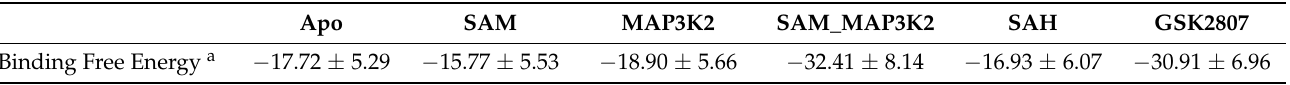
Table 3. Binding free energies of the SET and MYND domains toward the CTD. Apo SAM MAP3K2 SAM_MAP3K2 SAH GSK2807 Binding Free Energy a − 17.72 ± 5.29 − 15.77 ± 5.53 − 18.90 ± 5.66 − 32.41 ± 8.14 − 16.93 ± 6.07 − 30.91 ±